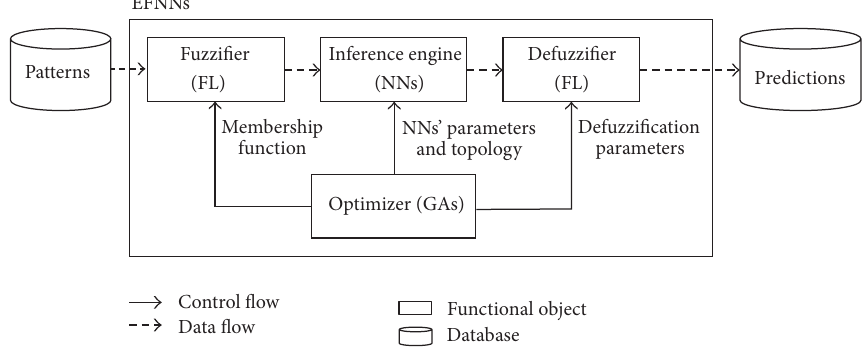
Figure 1: Architecture of Evolutionary Fuzzy Neural Networks.